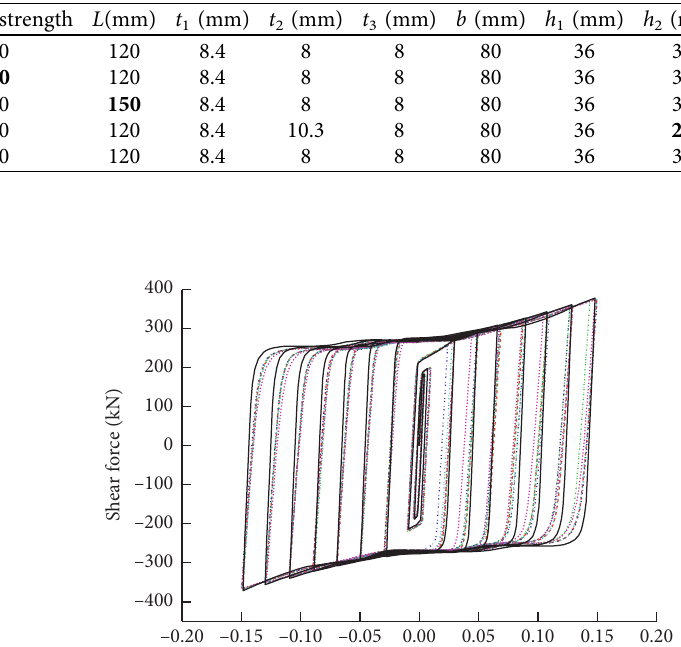
Table 2: Parameters of PCB-SLCC.